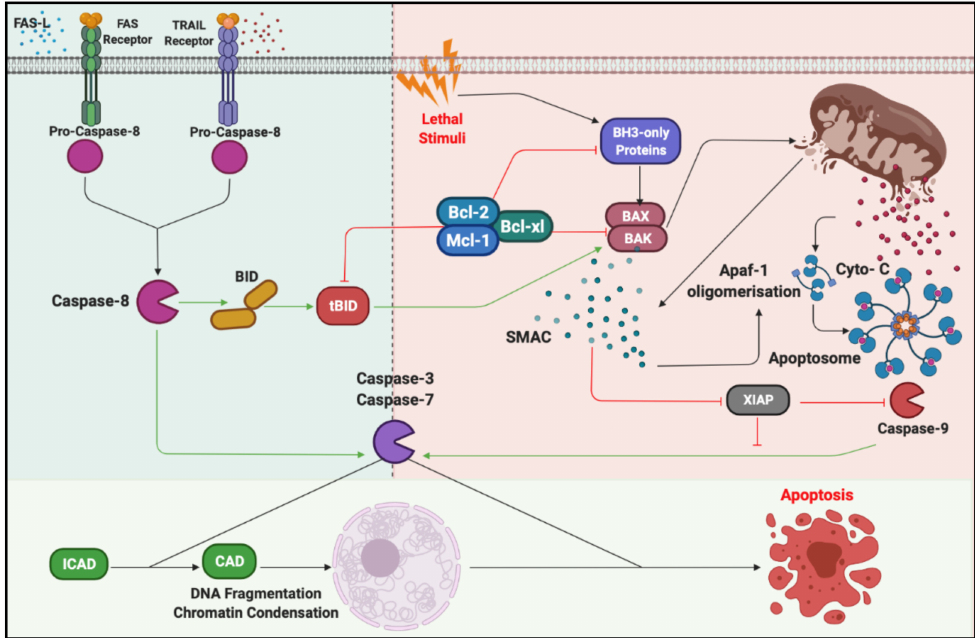
Figure 3. Mitochondrial pathways of cell death in T cells. Activation of CD95 or TNFR1 upon binding to CD95L results in the formation of DISC. Activation of caspase-8, in type I cells leads to direct activation of caspase-3 and then induction of apoptosis independent of mitochondria. In type II cells, caspase-8 cleaves the Bid proapoptotic protein to make truncated tBid. Next, tBid promote the oligomerisation of Bak/Bax complexes to form pores in the mitochondria outer membrane. Releasing Cyto-C in the cytosol activates caspase-9, which in turn activates caspase-3 to induce downstream events of apoptosis. TRAIL, TNF-related apoptosis inducing ligand; BID, BH3 interacting domain death agonist; CAD, caspase-activated DNase; ICAD, inhibitor of caspase-activated DNase; Bcl-2, B-cell lymphoma 2; Mcl-1, myeloid cell leukemia 1; Apaf1, apoptotic peptidase activating factor 1; Cyto-C, Cytochrome C; XIAP, X-linked inhibitor of apoptosis protein; TNFR1, tumor necrosis factor receptor 1; DISC, death inducing signaling